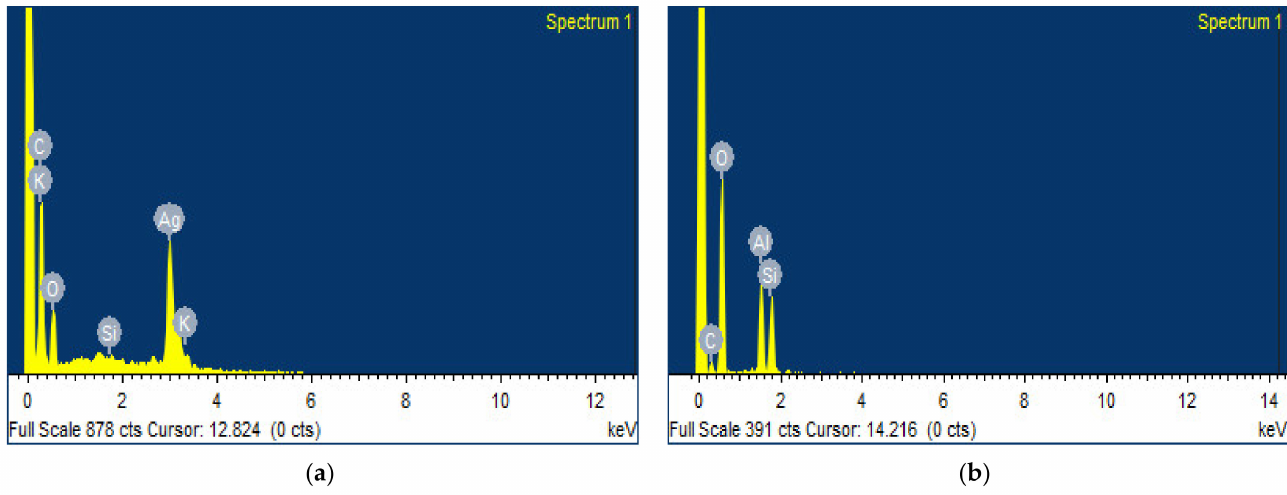
Figure 10. Energy-dispersive X-ray spectrum for ( a ) the topsoil layer; ( b ) the bottom soil layer.